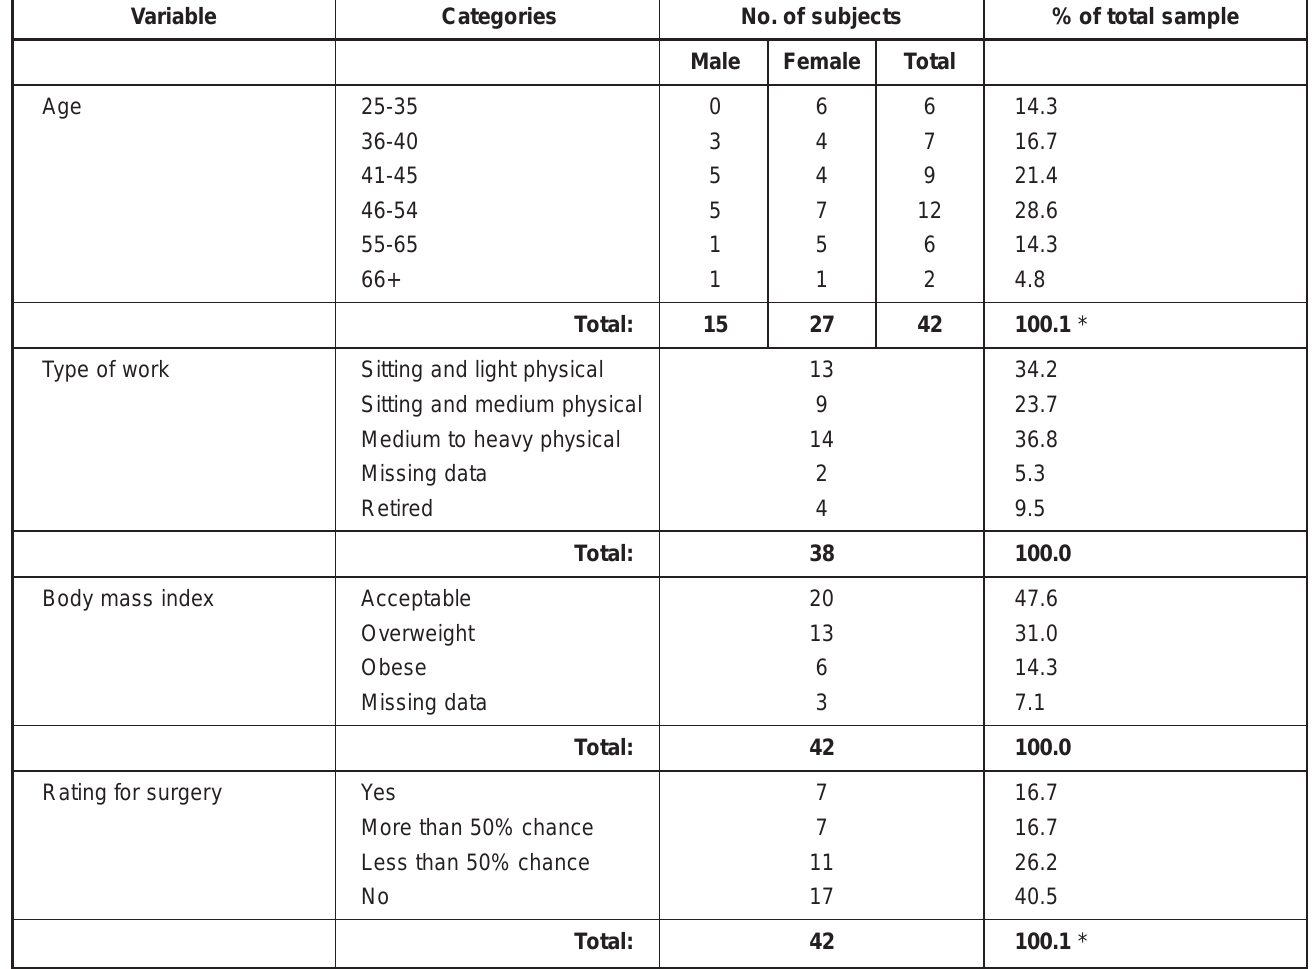
Table 1: Socio-demographic and medical data for subjects